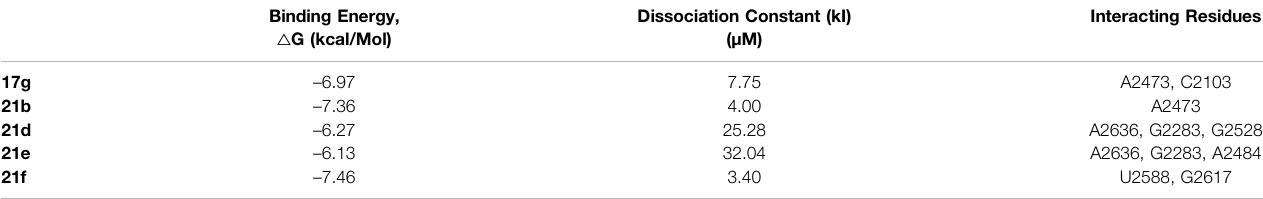
Interacting Residues